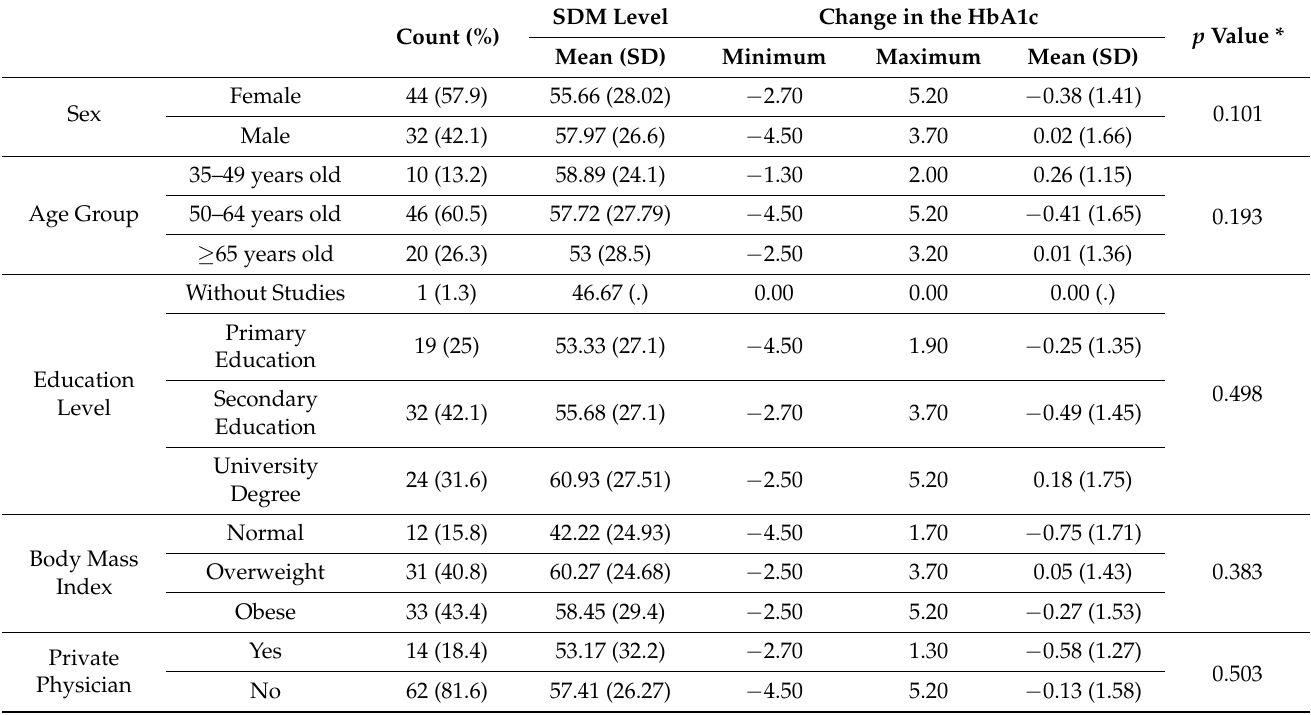
Table 1. Demographic characteristics of the